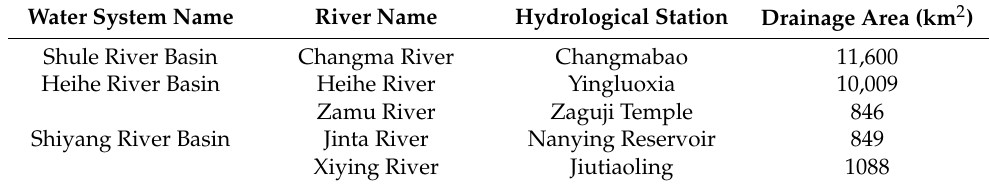
Table A1. Basic situation of the Hexi inland river